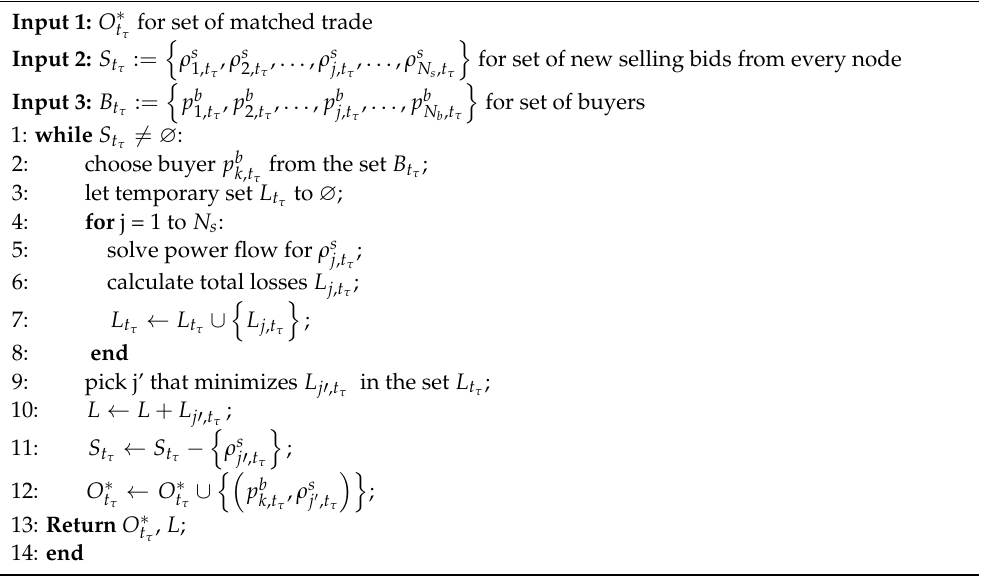
Algorithm 2. Matching algorithm for buyer i ∈ N b at time t τ in guided transaction